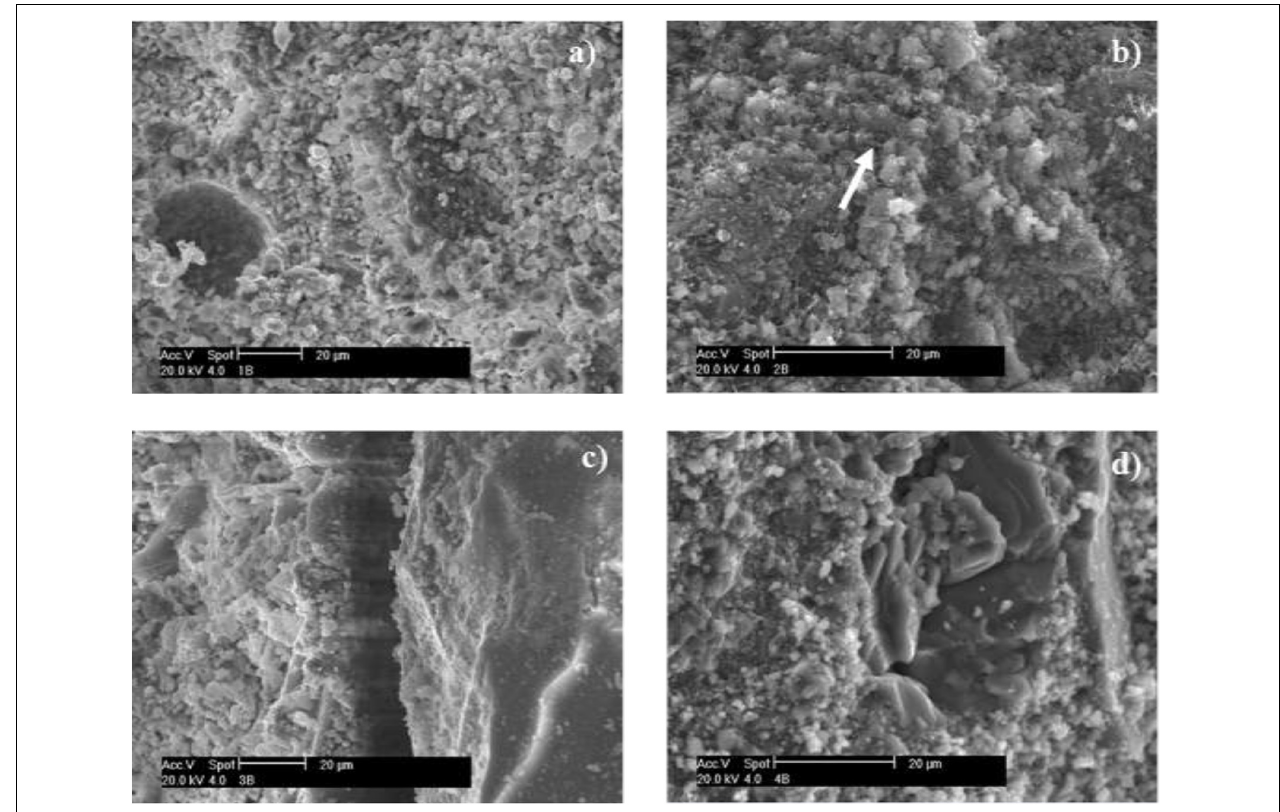
FIGURE 3 | SEM images of mortars manufactured with different aggregates and TiO 2 . (a) HL-S TiO 2 , (b) HL-A1 TiO 2 , (c) HL-A2 TiO 2 , (d) HL-A3 TiO 2 .